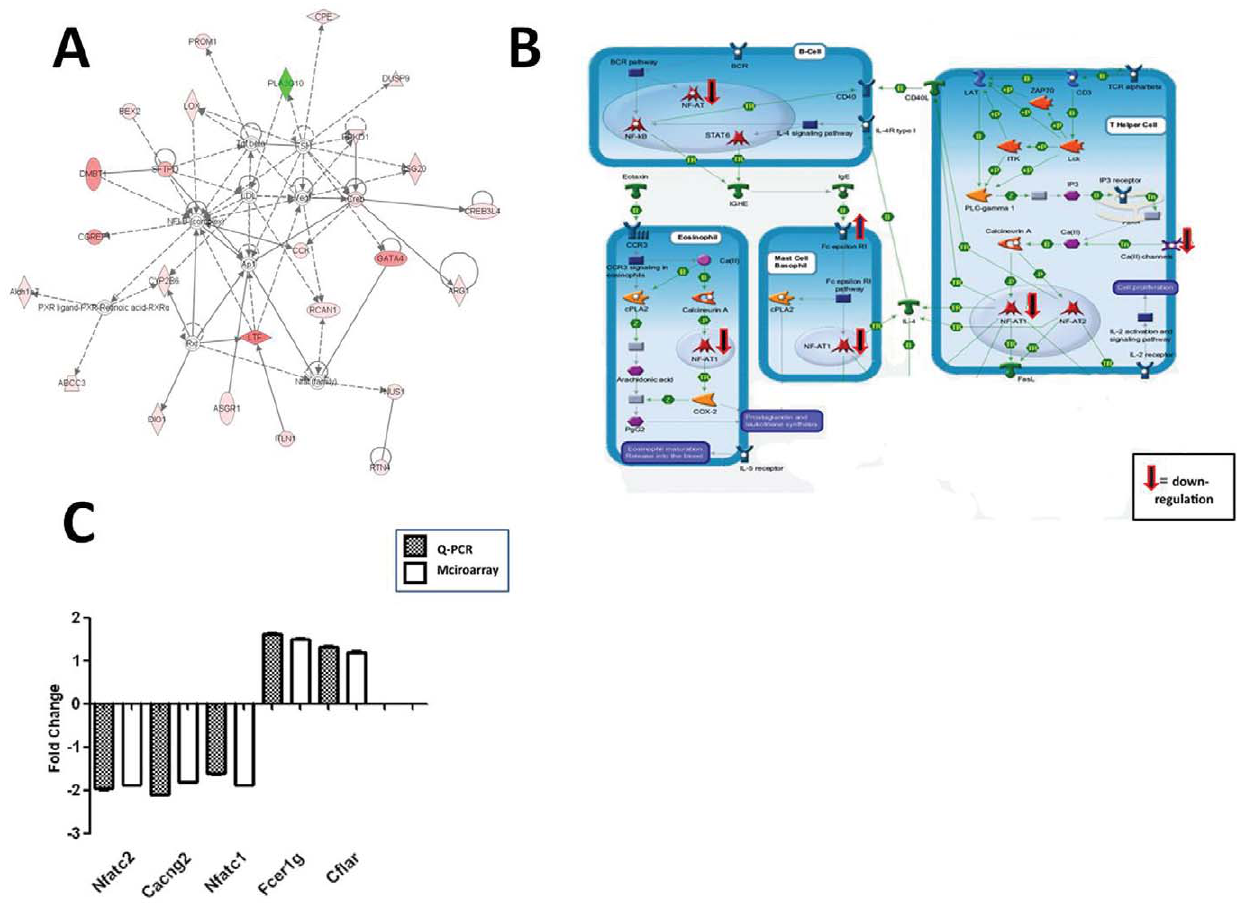
Figure 2. Network based analysis of genes affected by CD40:Fc treatment. Microarray analysis was performed on SG of CD40:Fc treated and control mice (n=4 each, treatment at 10 weeks, end of study at 20 weeks) and gene changes greater than 2 fold were used in the analysis and compared for biological functional pathways or biomarkers by an Ingenuity Pathway analysis (IPA). ( A ) The pathway of NF- k B and TGF- b was affected in CD40:Fc treated mice. Green colored shapes indicates upregulated genes, red colored shapes downregulated; gray colored shapes genes in the pathway that were not differentially expressed. Color intensity reflects the degree of differential expression. Triangles represent phosphatases; horizontal diamond, peptidases; vertical diamond, enzymes; horizontal oval, transcription factors; vertical oval, transmembrane receptors; trapezoid, transporters; circle, other type of protein. Dotted lines indicate an indirect interaction; solid line, direct interaction, solid arrow head indicates ‘‘acts on’’. ( B ) Metacore analysis of pathways linking differentially expressed genes to immune pathways. The differentially expressed genes are indicated along with the direction of change in expression. ( C ) Quantitative-PCR of selected genes shows agreement with microarray results. The results obtained using the microarray platform were validated by examining the correlation between the expression levels in the microarray and qPCR results obtained for a subset of genes.